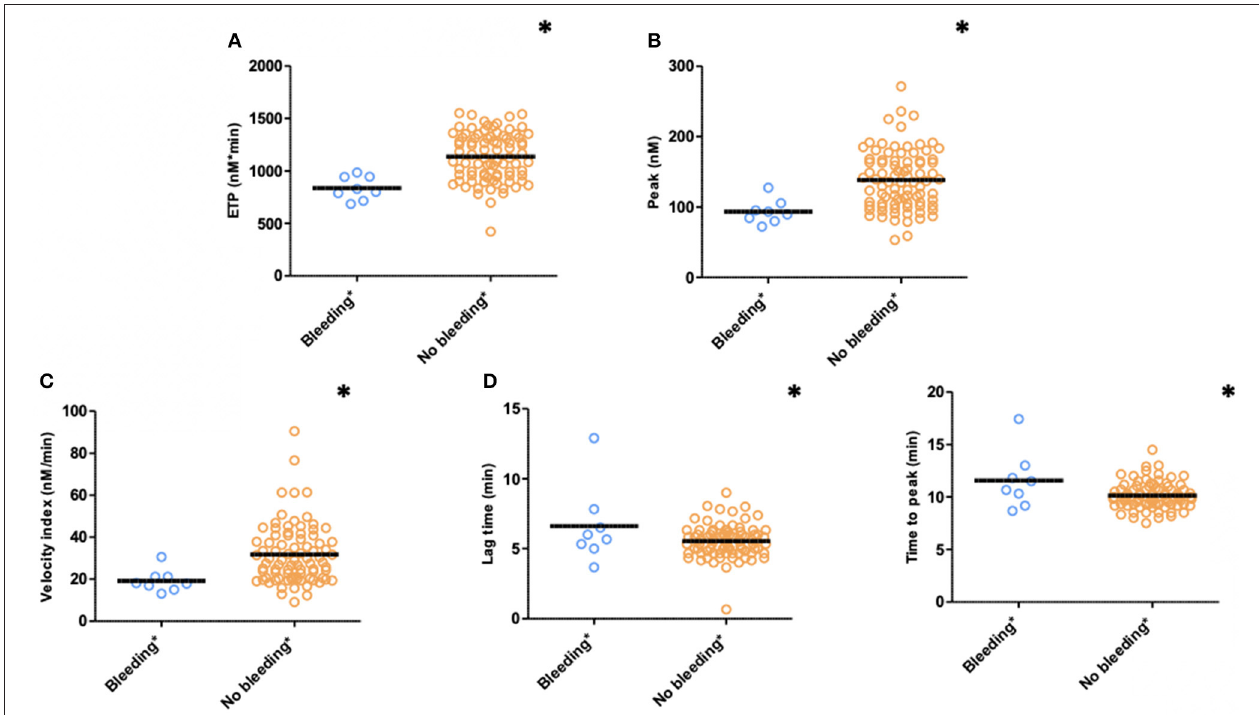
FIGURE 3 | Thrombin generation (TG) in PPP patients with ( n = 15) and without ( n = 78) clinically relevant bleeding ( N = 93) during follow-up (bleedings recorded at T2 and T3). (A) ETP, (B) Peak, (C) Velocity index, (D) Lag time, and (E) Time to peak. Significant lower ETP levels ( p ≤ 0.001), peak height ( p = 0.004), and velocity index ( p = 0.016) in patients with clinically relevant bleeding during follow-up. Significant longer time to peak ( p = 0.007) and lag time ( p = 0.036) in patients with clinically relevant bleeding. Means are indicated by lines. * p < 0.05. ETP, Endogenous Thrombin Potential; PPP, Platelet Poor Plasma; N, number of patients.